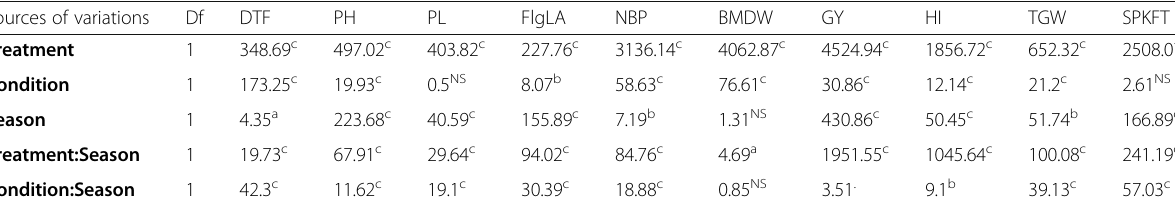
Table 2 Analysis of variance (F-values) for grain yield, yield components and agronomic traits among treatments, conditions and seasons for the diverse set of 280 lines Sources of variations